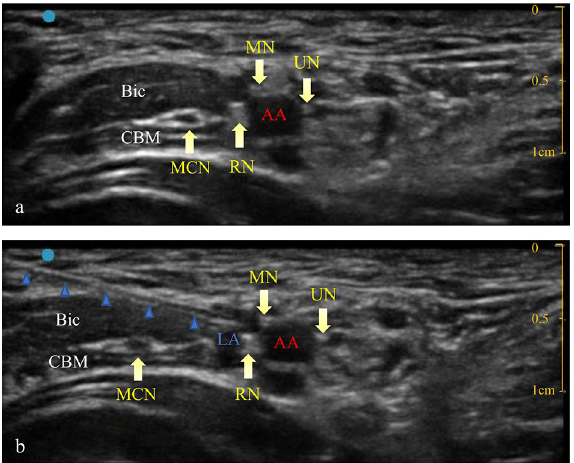
Figure 1. Ultrasound image preinjection ( a ) and ultrasound image postinjection ( b ). needle. AA: axillary artery; LA: local anaesthetics; MCN: musculocutaneous nerve; RN: radial nerve; MN: median nerve; UN: ulnar nerve; Bic: biceps brachii muscle; CBM: coracobrachialis